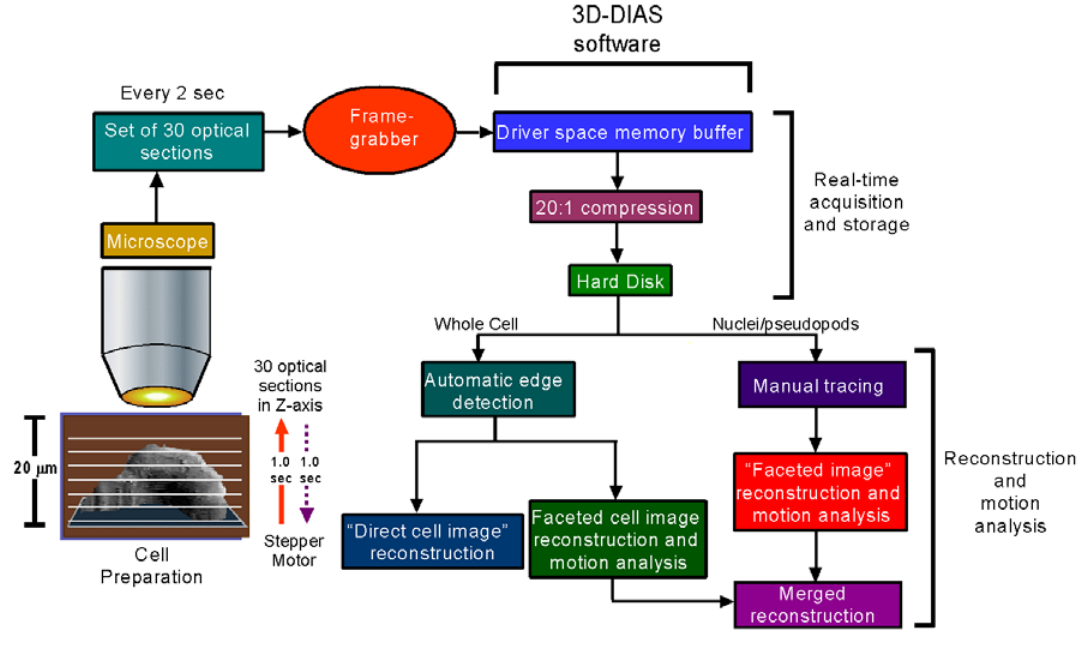
FIGURE 2 . The major components of “3D-DIAS”. A set of 30 optical sections through a live translocating cell is acquired in a 1-s time interval through DIC optics. Optical sections are digitized into a memory buffer and processed as described in the scheme (see [12] for